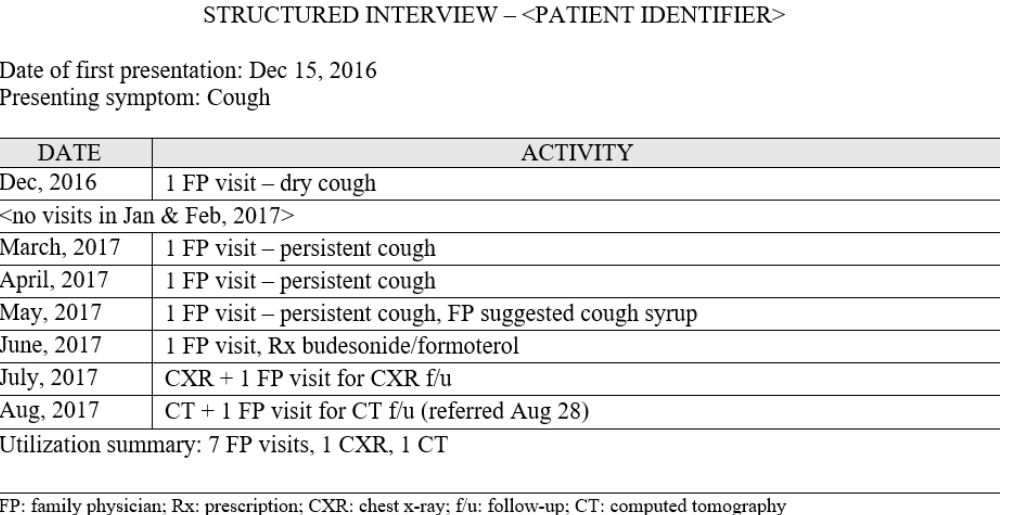
Figure 3. Summary of the interview data shown as the number of healthcare utilization activities by month.